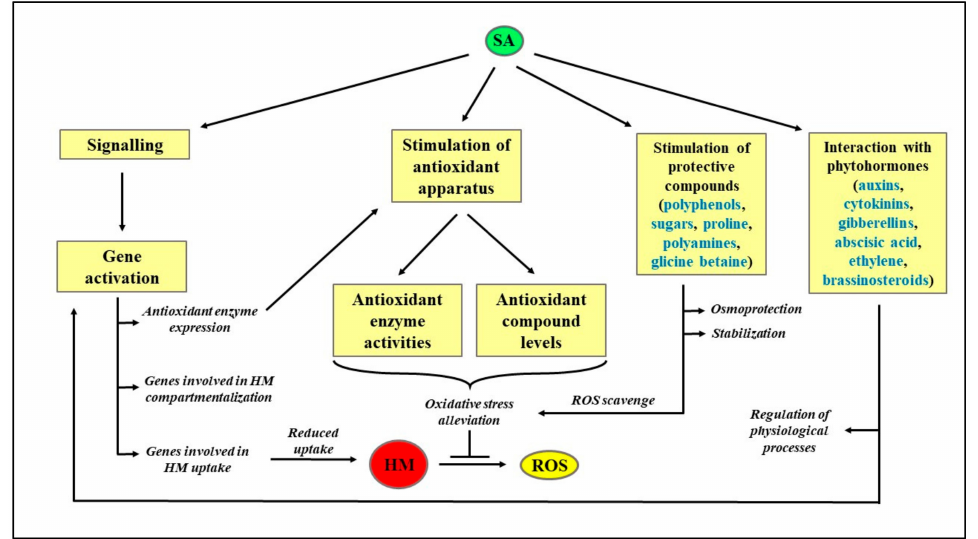
Figure 2. Schematization of the protective role exerted by SA in HM-stressed plants. HM: Heavy metals; ROS: Reactive oxygen species; SA: Salicylic